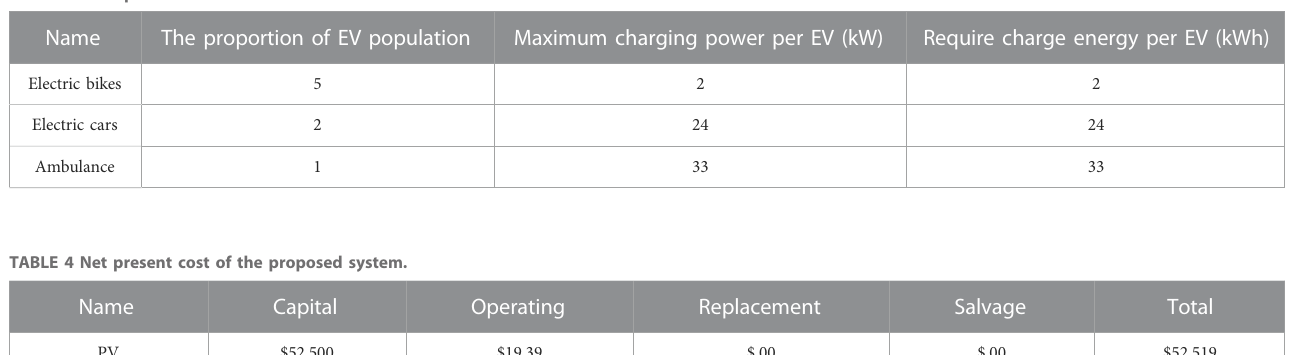
TABLE 3 Load pro fi le of EVs.